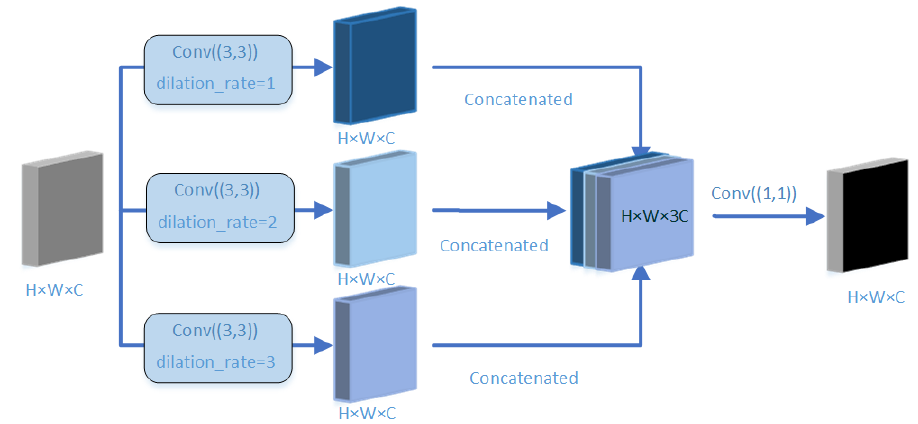
Figure 8. Feature fusion: first, different dilated convolution rates are used for feature extraction, and then, a 1 × 1 convolution operation is used to reduce the feature map, thereby reducing computational complexity.